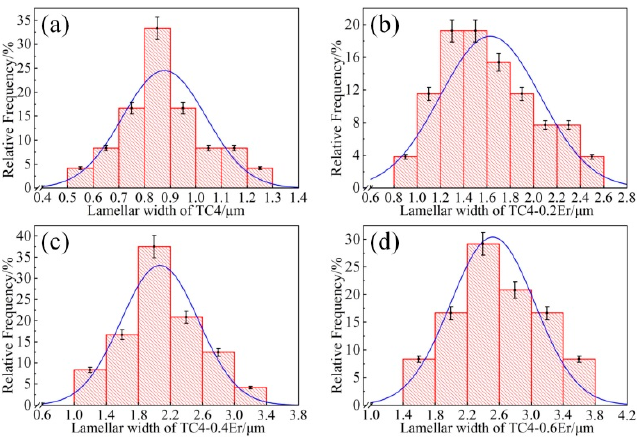
Figure 6. Size distribution of the lamellar width of Ti6Al4V- x Er casting alloys: ( a ) x = 0; ( b ) x = 0.2; ( c ) x = 0.4; ( d ) x = 0.6 wt %.